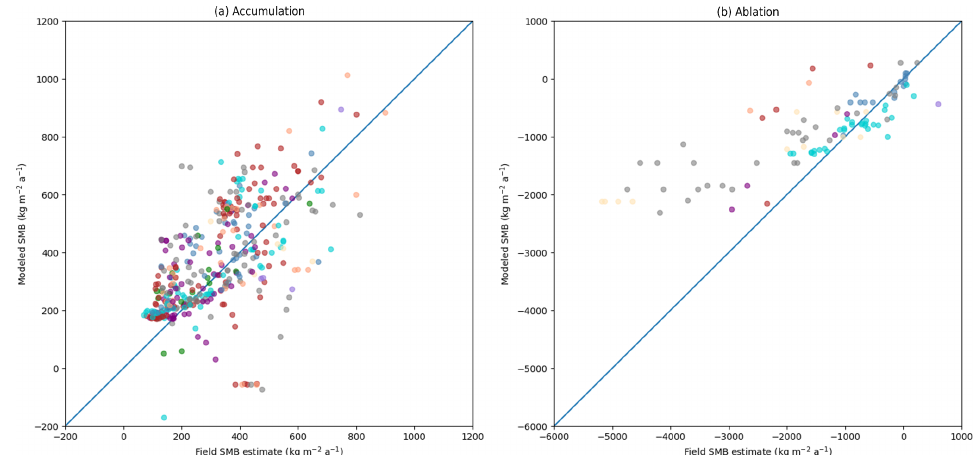
Figure 14. CESM annual SMB vs. observed estimates at locations taken from accumulation (a) and ablation zones (b) . Observational data were compiled as detailed in Sect. 2. In both figures, colors correspond to the eight major drainage basins, as shown in Fig. 1, and the 1 : 1 line is drawn in blue.